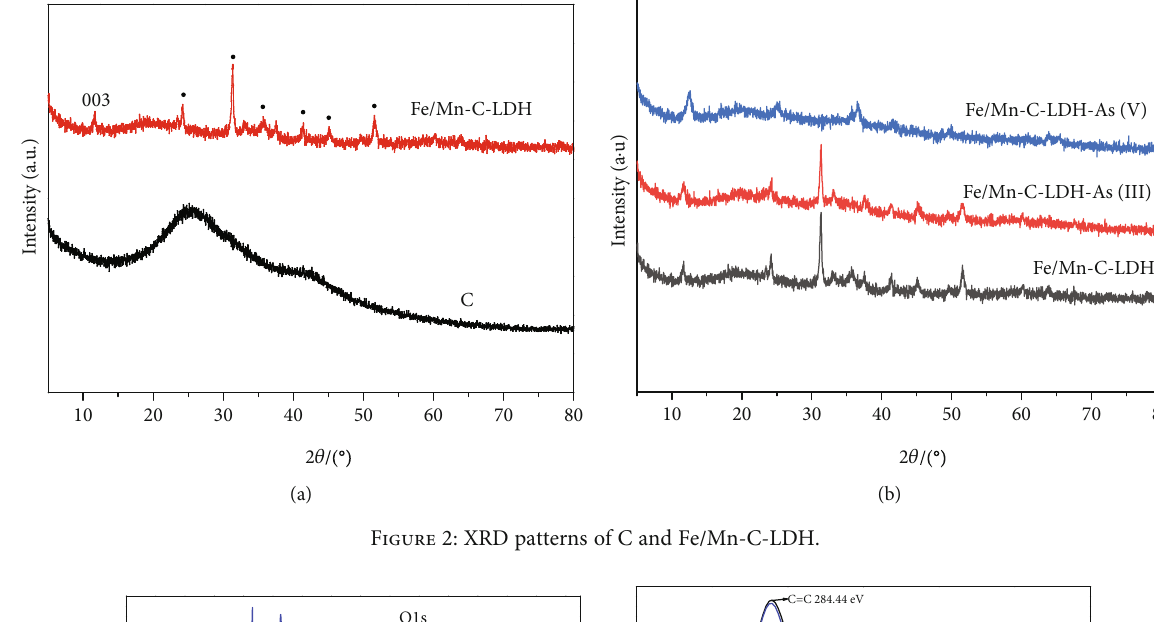
Figure 2: XRD patterns of C and Fe/Mn-C-LDH.